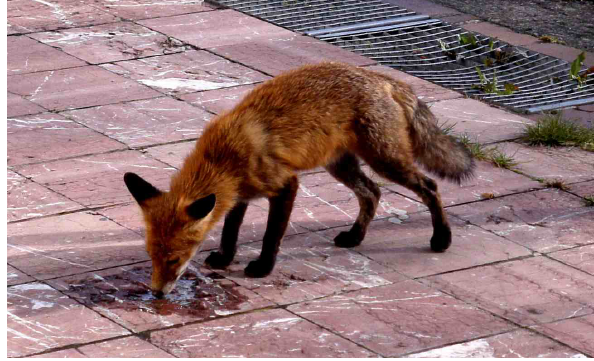
Figure 27. Wildlife inside of the sheltered station compound.